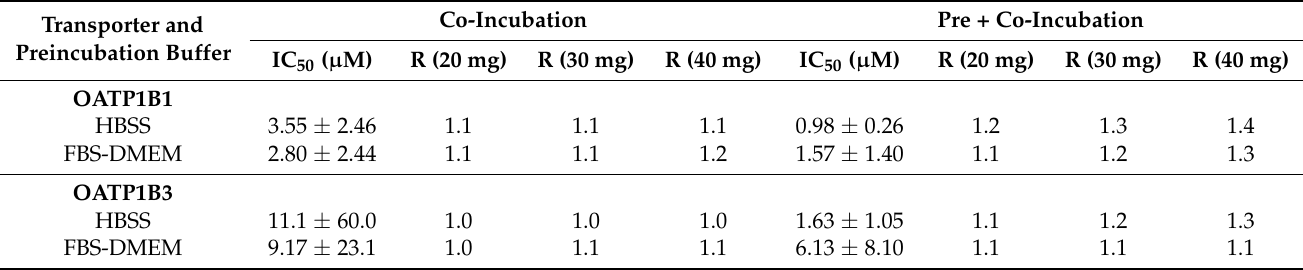
Figure 3. Effects of preincubation with nicardipine in HBSS buffer or FBS-containing medium on the IC 50 values for OATP1B3. OATP1B3-mediated transport of [ 3 H]-CCK-8 is expressed as a percentage of vehicle control after 30 min preincubation in nicardipine-containing HBSS buffer ( A ) or FBS–DMEM ( B ) (open squares), coincubation (closed circles) and pre + coincubation (open circles) scenarios with nicardipine (0.05–4 µM) as the inhibitor are as described in the Materials and Methods. Data represent mean ± SEM ( n = 3 in triplicate). The IC 50 values were determined by fitting dose-response curves to the data using nonlinear regression analysis. Solid (coincubation) and dashed (pre + coincubation) lines represent the fitted lines. Table 2. IC 50 values for nicardipine against OATP1B1 and OATP1B3 and predicted AUC ratios (R) of OATP1B1- and OATP1B3-mediated DDIs using the R-value